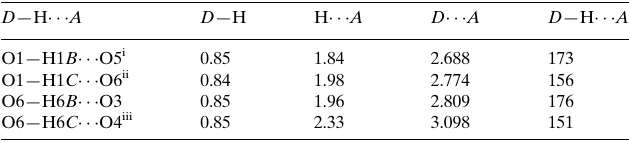
Hydrogen-bond geometry (A˚ , (cid:3)